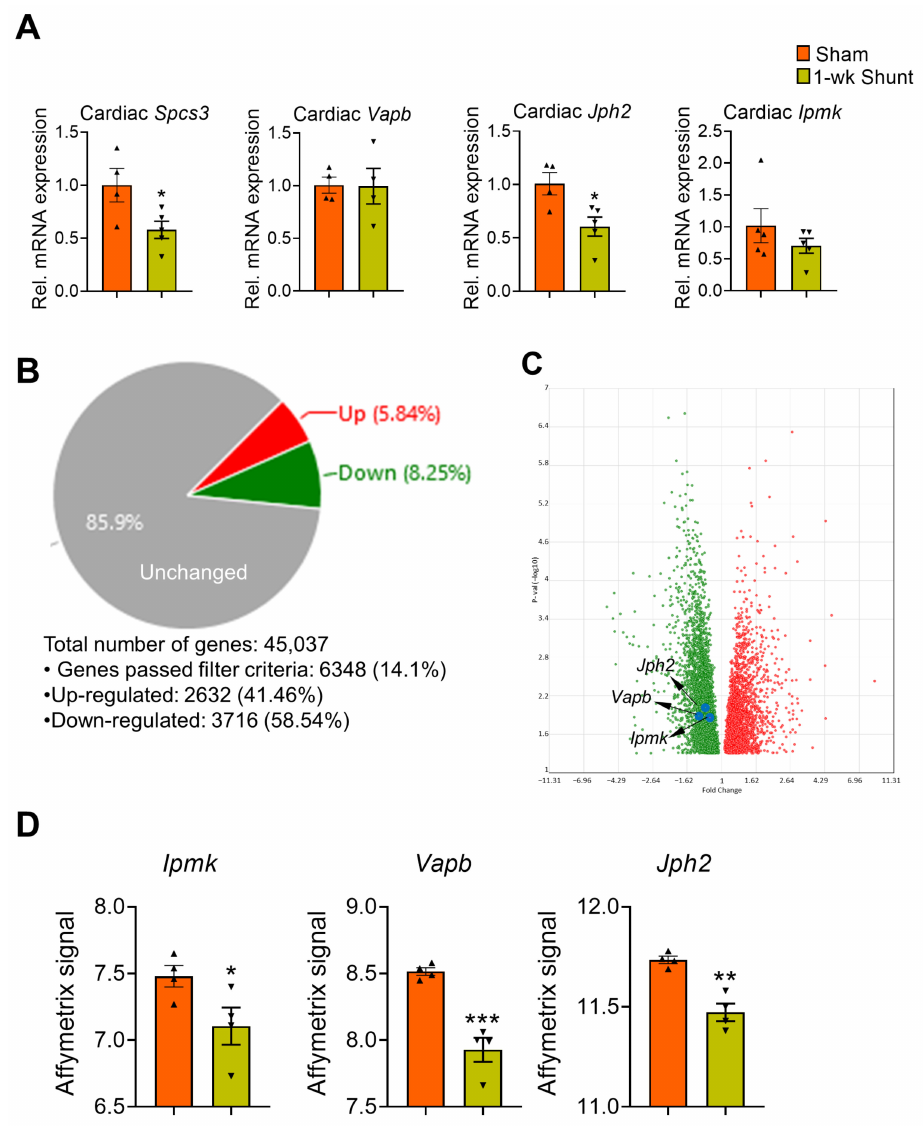
Figure 7. mRNA expression of the selected genes at 1 week after shunt. ( A ) qPCR analysis show- ing the mRNA expression level of the four selected candidate genes. ( B ) Pie chart summariz- ing the percentage of upregulated (5.84%), downregulated (8.25%), and unchanged (85.9%) genes in 1-week-shunt vs. sham mouse hearts. ( C ) Volcano plot shows downregulation of Jph2 , Vapb and Ipmk in 1-week-shunt vs. sham mouse hearts. The selected candidate genes are shown with blue dots. Filter criteria: fold Change: >1 or < − 1 and p -value < 0.05. ( D ) Barplot showing the Affymetrix signal intensity for the Ipmk , Vapb , and Jph2 genes compared between 1-week-sham and shunt mouse hearts. Values are mean ± SEM, n = 4–5 hearts/group. * p < 0.05, ** p < 0.01, *** p < 0.001 vs. sham, two-tailed unpaired Student’s t